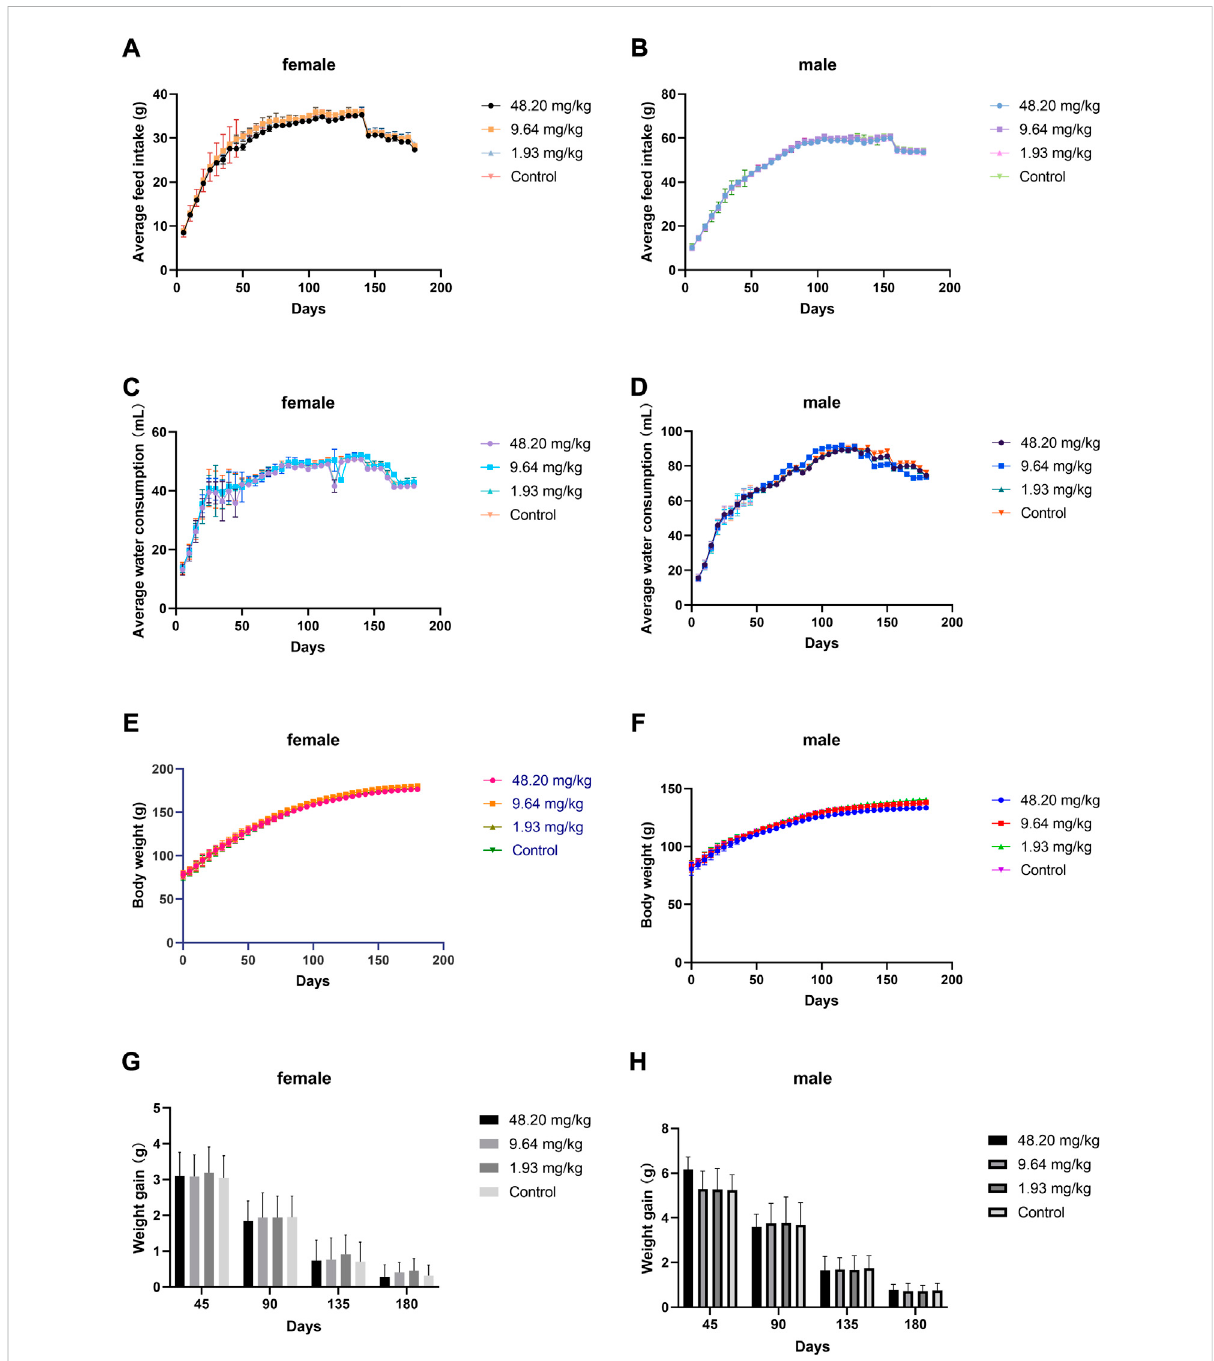
FIGURE 5 Effects of feeding MPTA for 180 days on feeding, drinking, body weight and weight gain of rats (A) Effect of MPTA on feed intake of female rats; (B) Effect of MPTA on feed intake of male rats; (C) Effect of MPTA on water intake of female rats; (D) Effect of MPTA on water intake of male rats; (E) Effect of MPTA on body weight of female rats; (F) Effect of MPTA on body weight of male rats; (G) Effect of MPTA on weight gain of female rats; (H) Effect of MPTA on weight gain of female